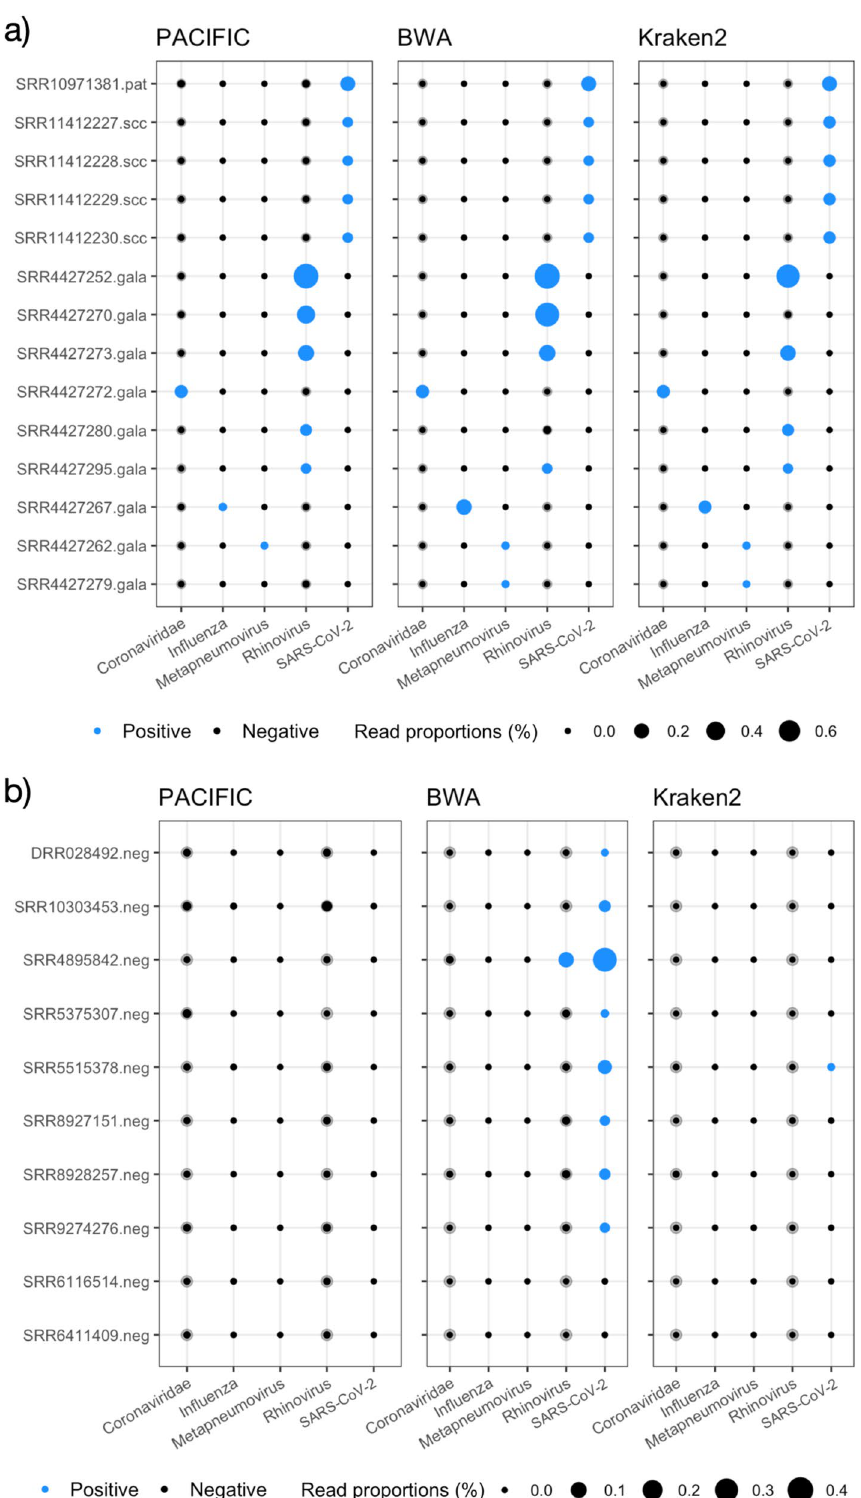
Figure 5. PACIFIC, BWA-MEM and Kraken2 virus predictions in RNA-seq data. Transparent grey filled circles represent detection thresholds for each class, overlaid with black filled circles representing the percentage of predicted reads using PACIFIC (left panel), BWA-MEM (centre panel) and Kraken2 (right panel). Circles are filled blue when the percentage of reads for a class are above detection thresholds described in Table 2. RNA-seq samples (y-axis) are labelled with NCBI SRA run accessions and abbreviations for sample type. ( a ) RNA-seq samples predicted to be positive for at least one viral class by PACIFIC, BWA-MEM, or Kraken2. Samples include a SARS-CoV-2-infected human patient bronchoalveolar lavage fluid sample (.pat), four in vitro SARS-CoV-2-infected NHBE cell lines (.scc) and 9 samples from the GALA II cohort (.gala). ( b ) Human RNA-seq samples without expected viral infections (.neg; n = 10). Samples were selected from the NCBI SRA database with no recorded evidence of